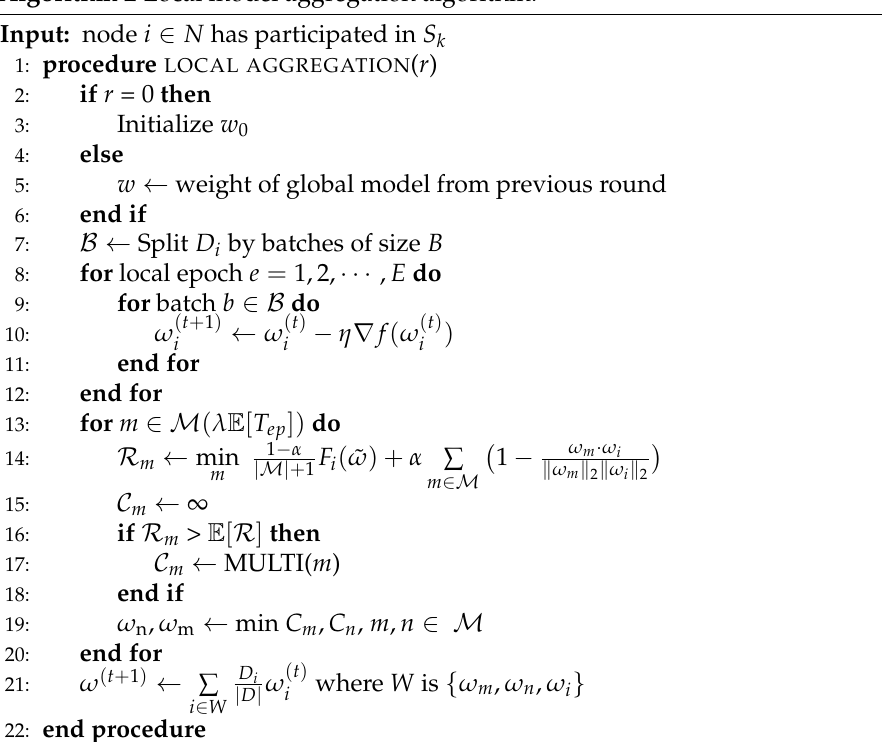
Algorithm 2 Local model aggregation